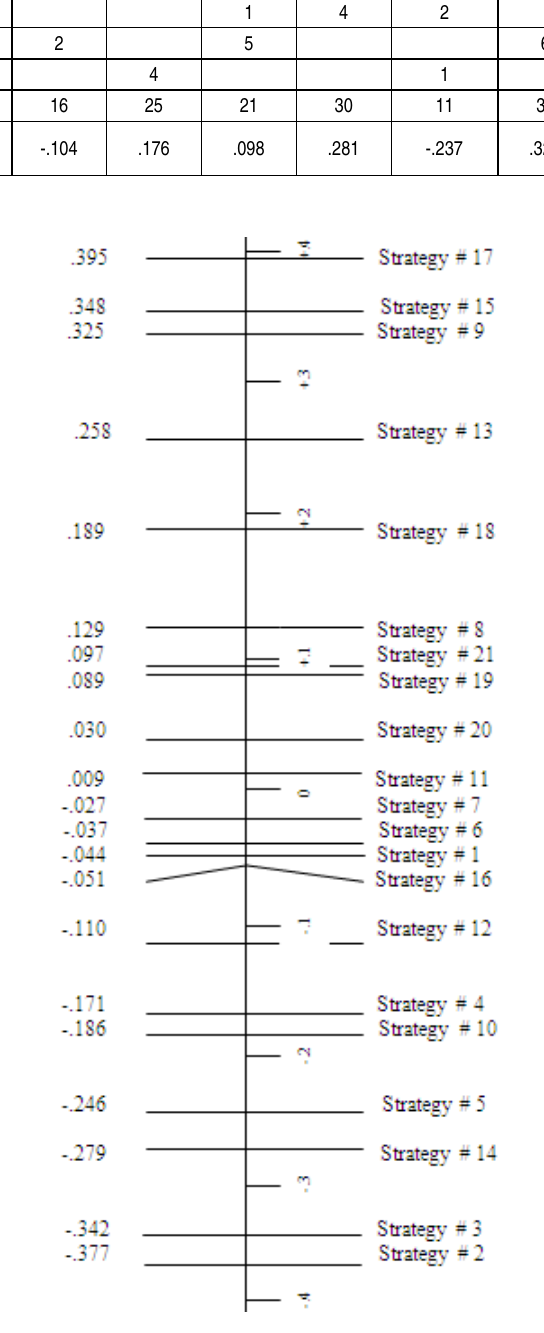
Fig. 1. Linear scale depicting Guttman scores for procurement strategies for the introduction